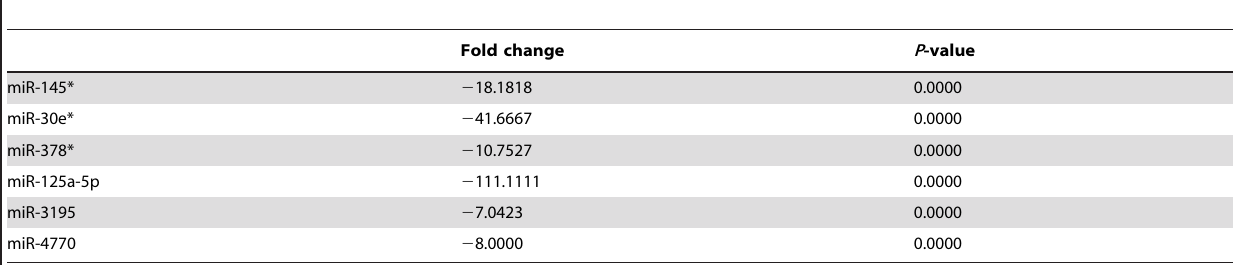
Table 2. Expression levels of miR-145*, -30e*, -378*, -125a-5p, -3195, and -4770 in an independent sample